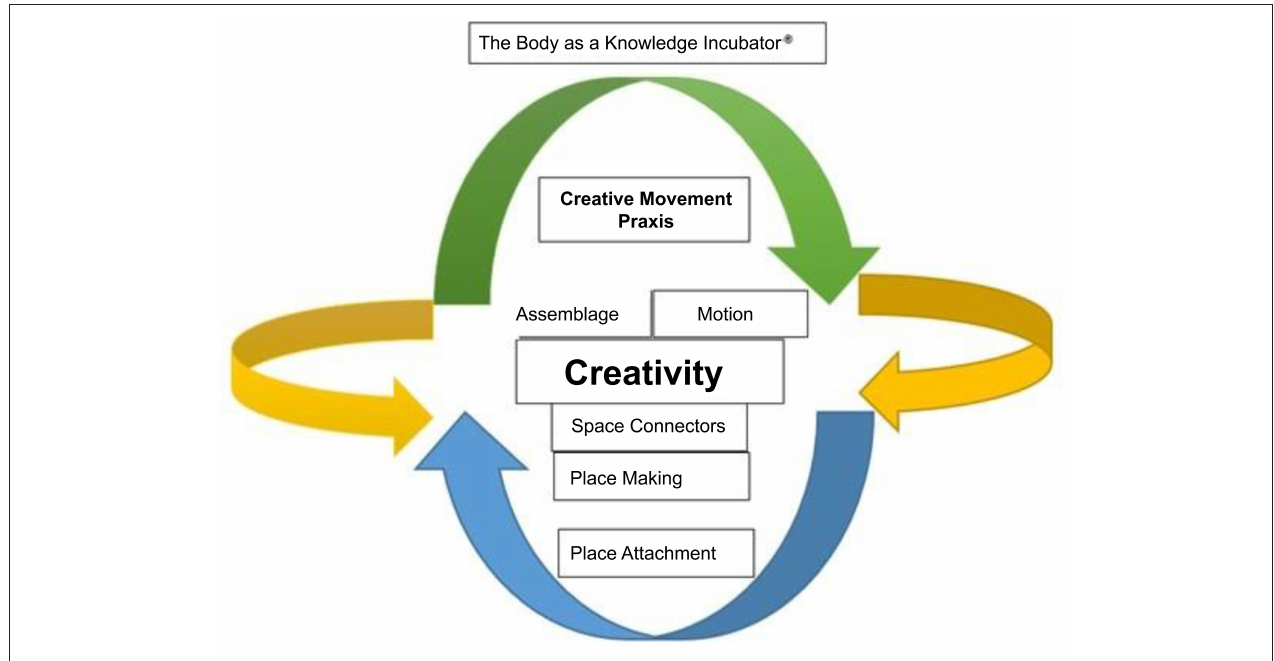
FIGURE 1 | The Body as Knowledge Incubator TM . Dhillon (2018), Biso (2020), and Dhillon and Ulmer